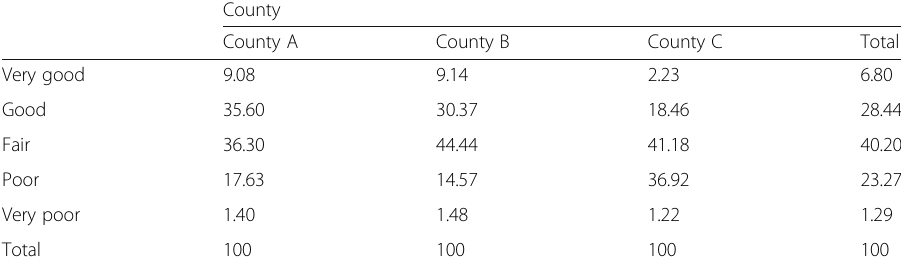
Table 6 Elders ’ self-rated health in different counties